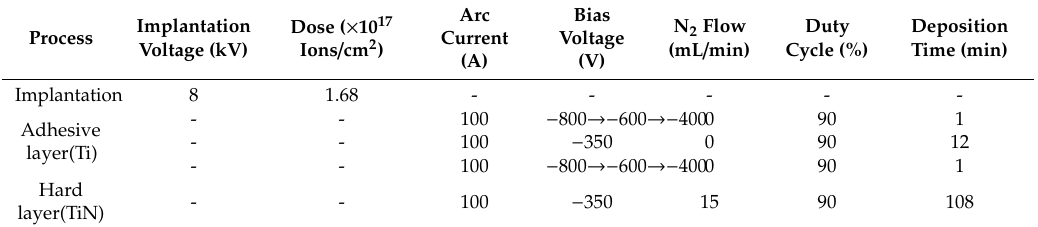
Table 1. TiN coatings preparation process and